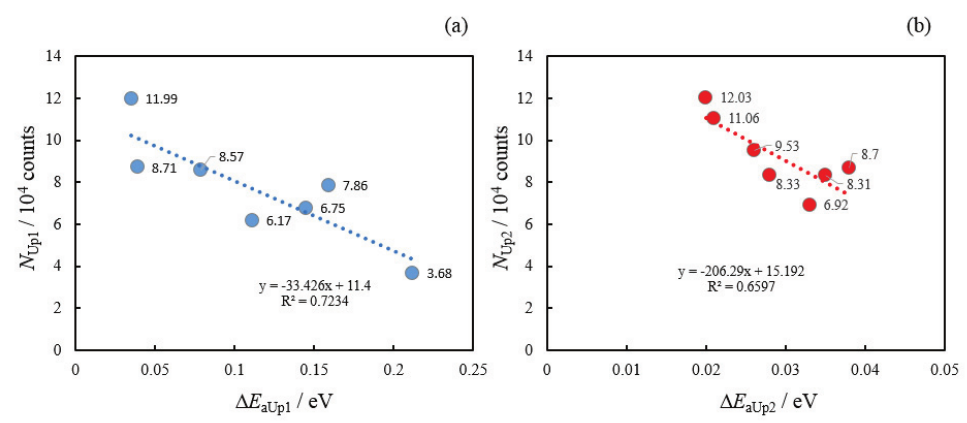
Figure 10 . Plots of the total count of PE electrons emitted during the Up1 and Up2 temperature scans against the activation energy for both scans, ( a ) N Up1 vs. Δ E aUp1 and ( b ) N Up2 vs. Δ E aUp2 for all scratching environments.